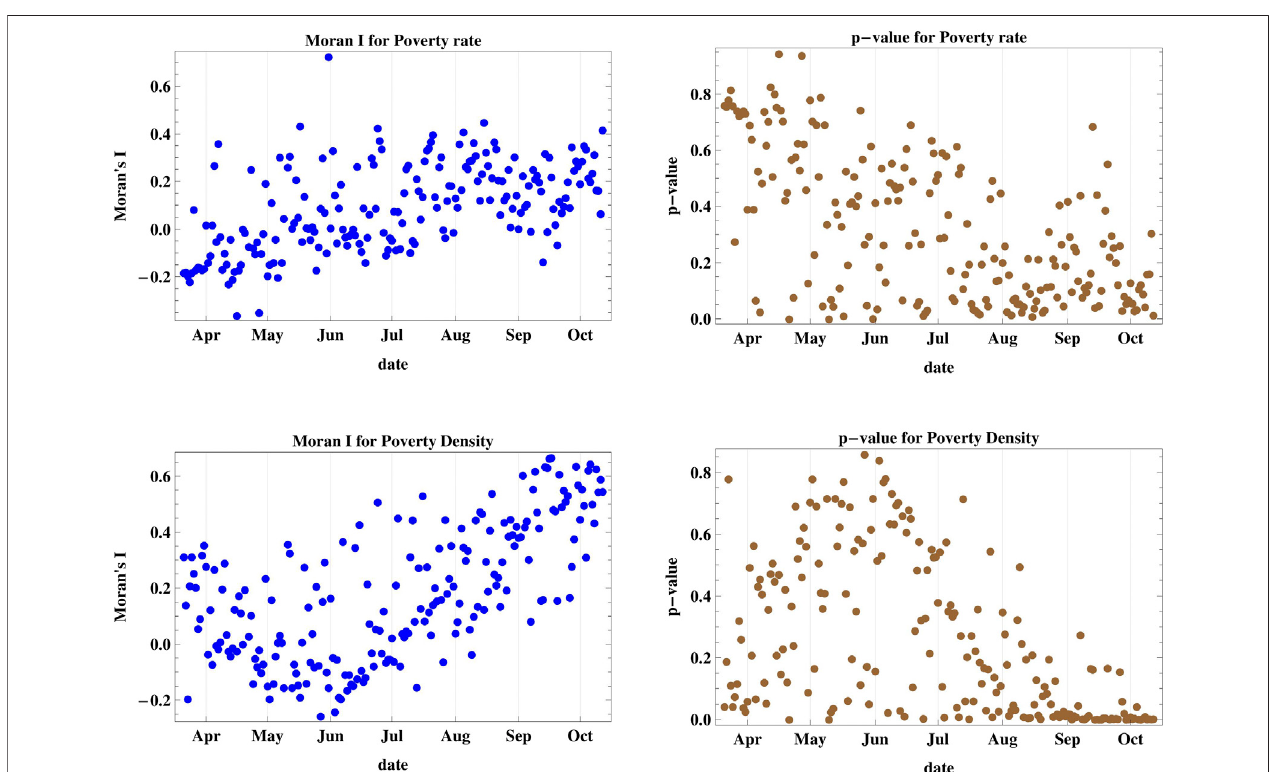
FIGURE 4 | Moran ’ s I index and its corresponding p -value for cases V and VI accounting for regional poverty rate and poverty density. The poverty rate is not a decisive factor for spatial spread but when we consider the poverty density, we obtain spatial clustering starting on the end of